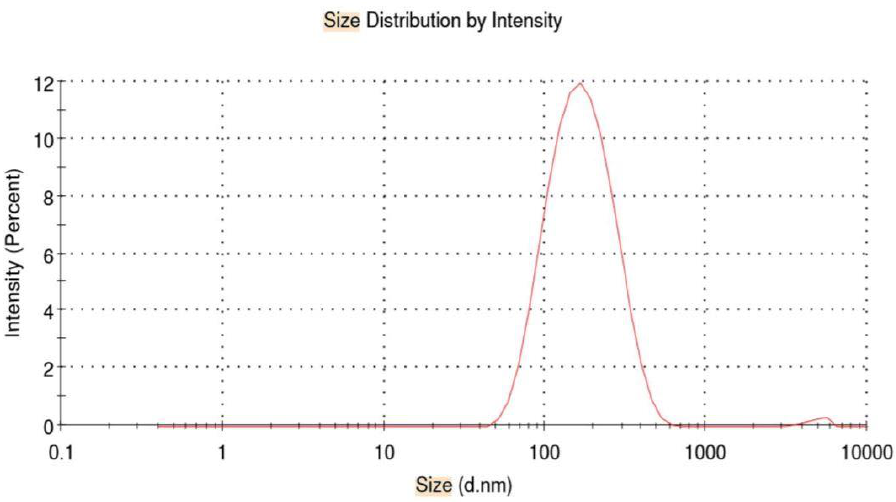
Figure 4. Size distribution of Cur / ALG-GA NPs.